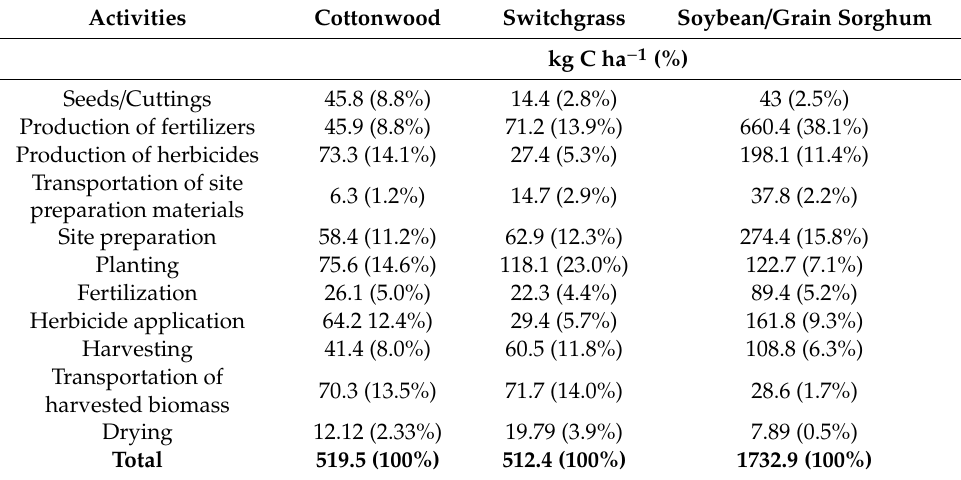
Table 2. Total carbon emitted from each crop during the first three years in the life cycle, averaged across three